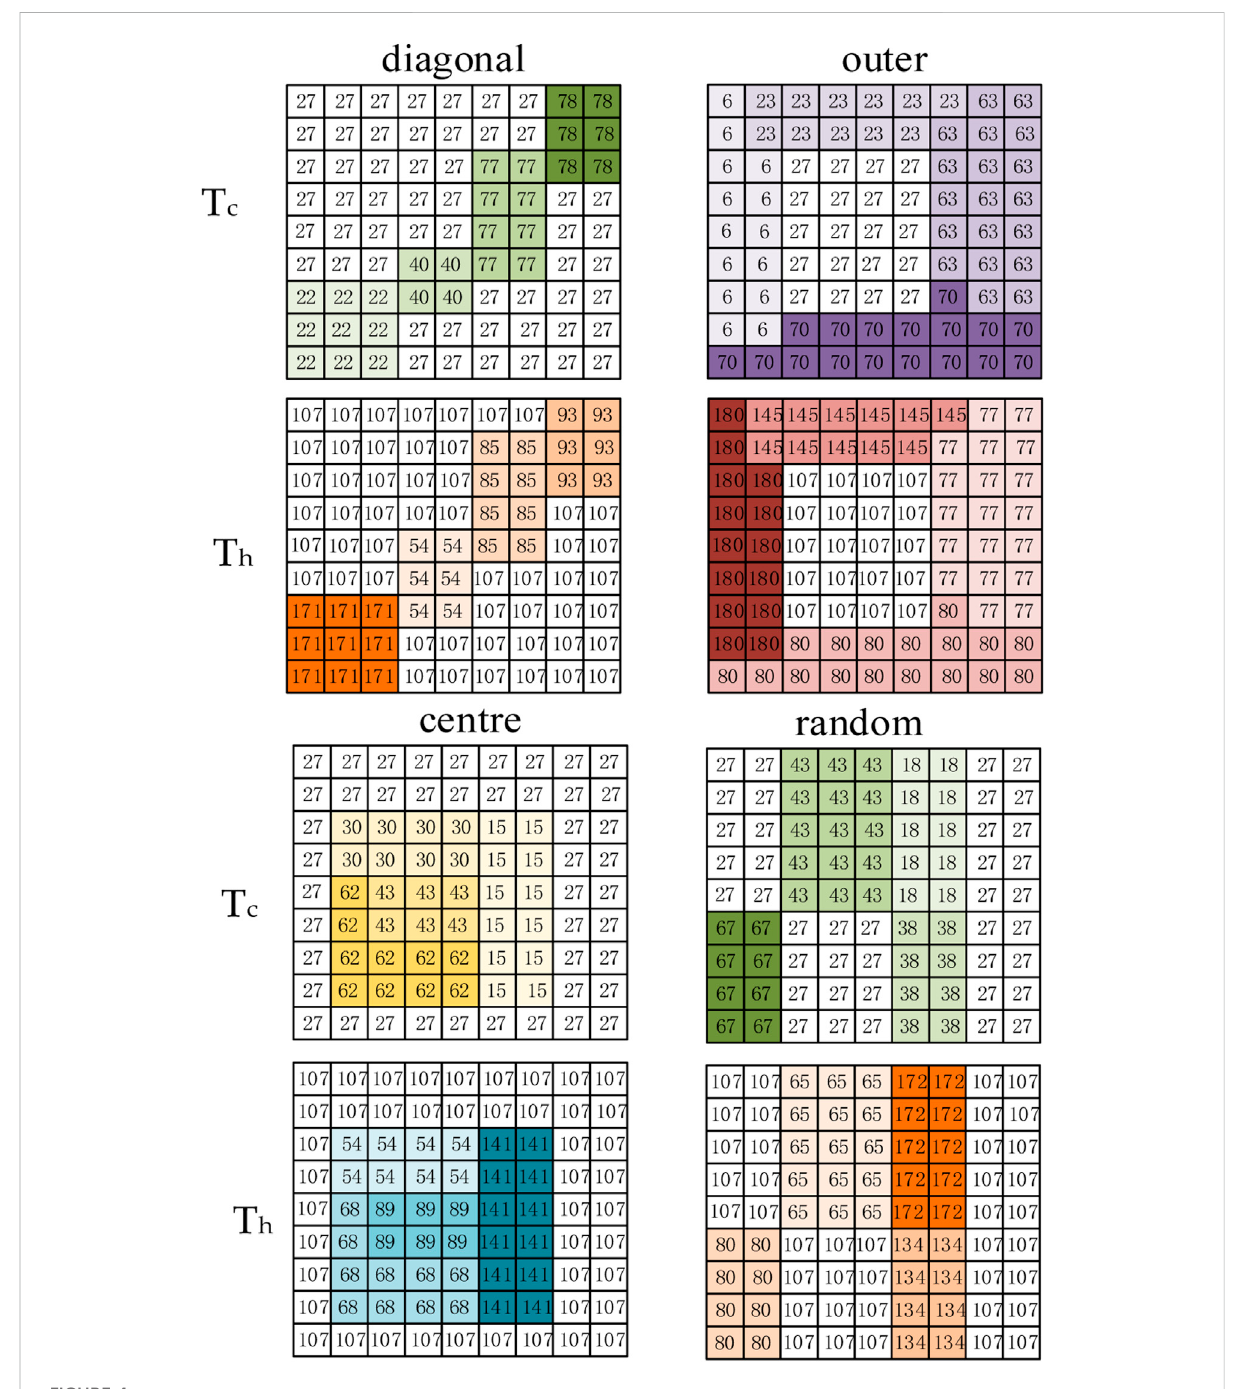
FIGURE 4 Four NTD patterns in the 9 × 9 symmetric TEG